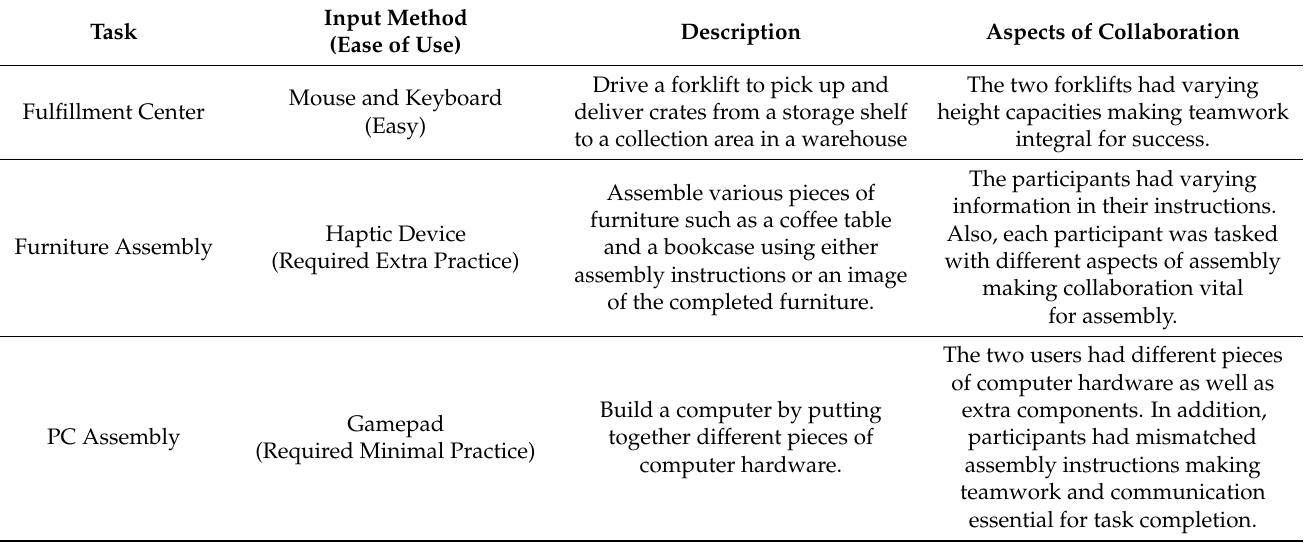
Figure 1. Collaborative tasks used for data collection. Table 1. Description of the collaborative tasks.